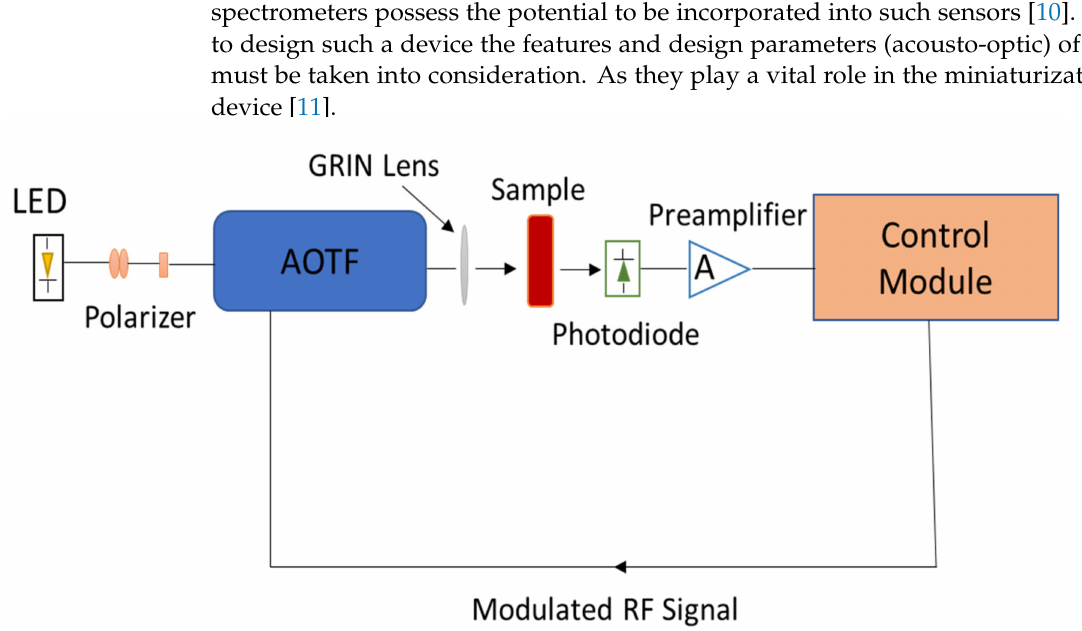
Figure 1. A schematic of the experimental setup of an AOTF-based